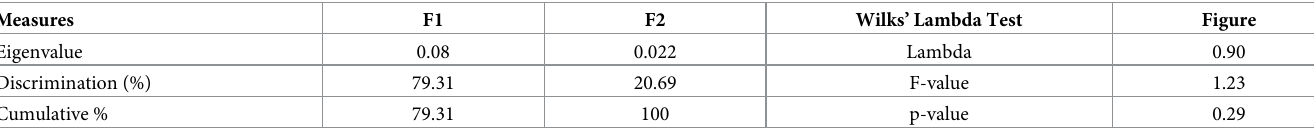
Table 12 denotes the descriptive degree of observed inter-organizational trust variables at three different groups of the company.